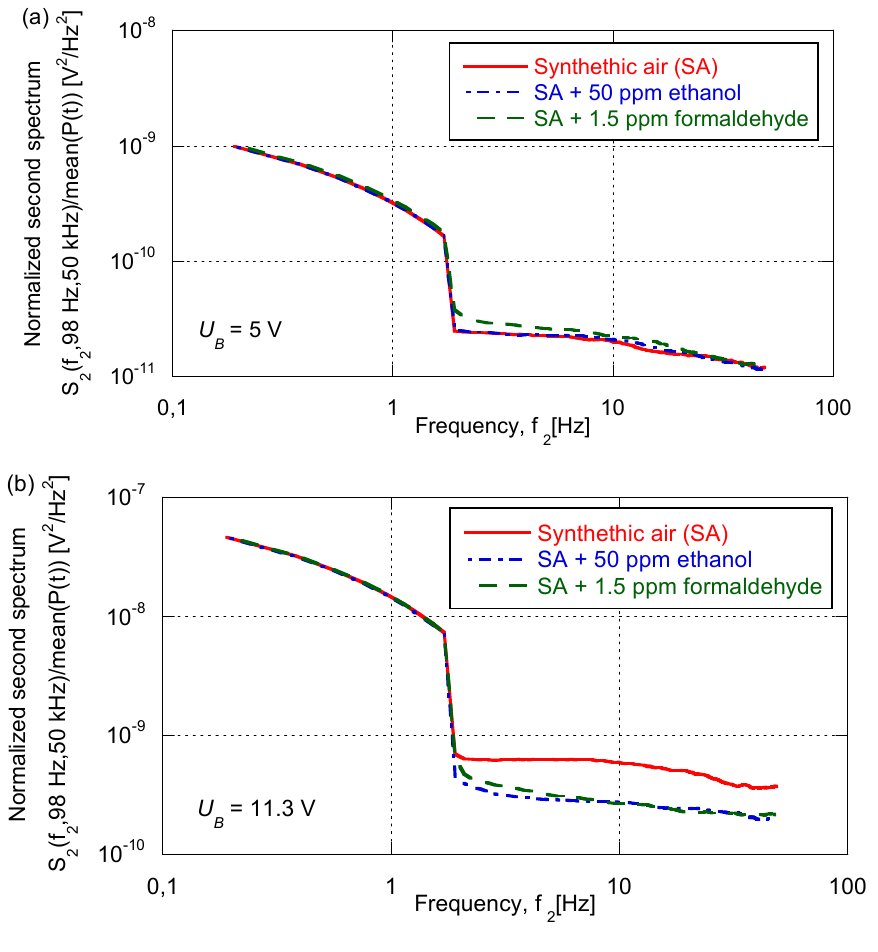
Figure 5. Second spectra for voltage fluctuations across an AuNP-based gas sensor exposed to the shown gases at the stated bias voltage ( U B ). The spectra were normalized to attain the same level at f 2 = 0.19 Hz.